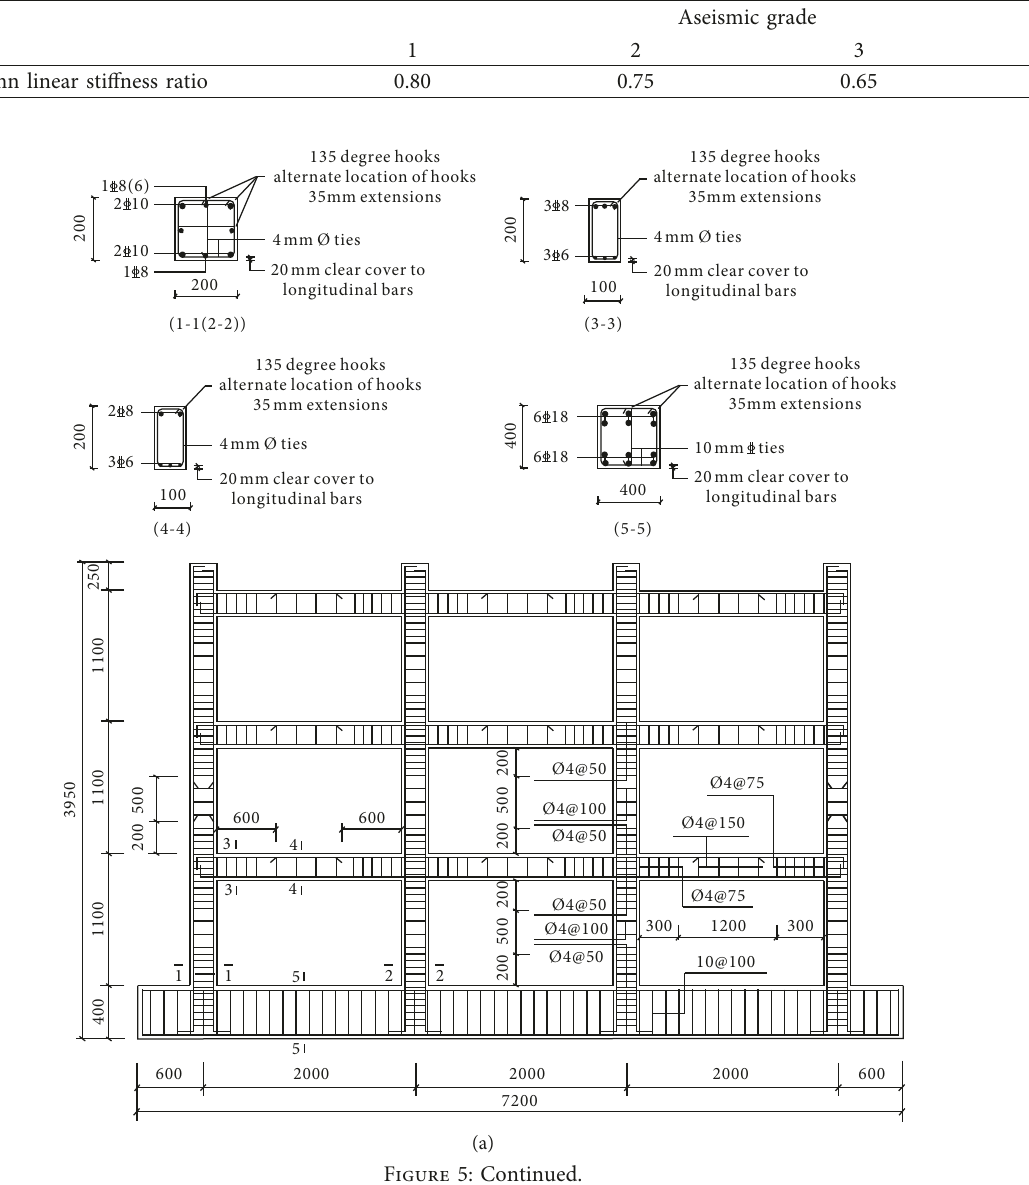
Table 2: Limit values of beam-to-column stiffness